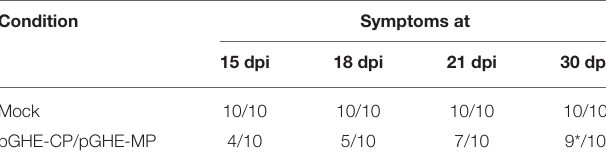
TABLE 2 | Occurrence of symptoms with time (days post inoculation, dpi) in plants agroinoculated with pGHE-CP and pGHE-MP mediated by Agrobacterium tumefaciens LBA4404 compared with the mock control plants after challenging with CGMMV